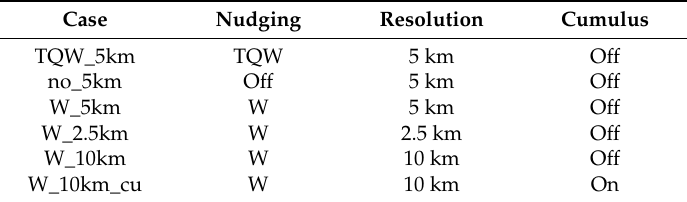
Condition settings of WRF simulations to determine the optimal setting for SST sensitivity analysis. Case Nudging Resolution Cumulus